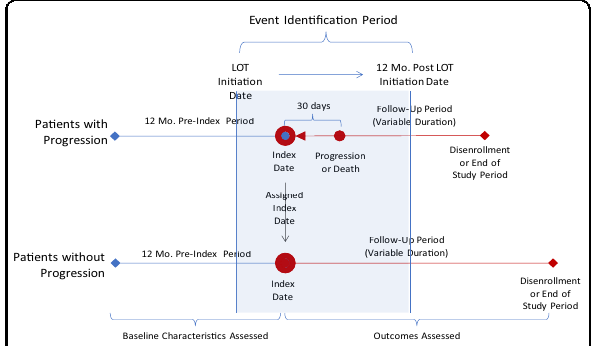
Fig. 1 Study design. For each LOT, progression status was assessed based on claims observed during an “ event identi fi cation period ” , de fi ned as the fi rst 12-month period after LOT initiation date (small red circle). For patients with progression, the “ index date ” (large red circle) was de fi ned as the date 30 days prior to documented progression (in order to capture care during the “ prodromal ” period and terminal care for those who died). For patients without progression, index date was randomly assigned to ensure similar distribution of time from treatment initiation to index date as for patients with progression. Footnote: Event = Progression or death. LOT = Line of therapy. Mo =